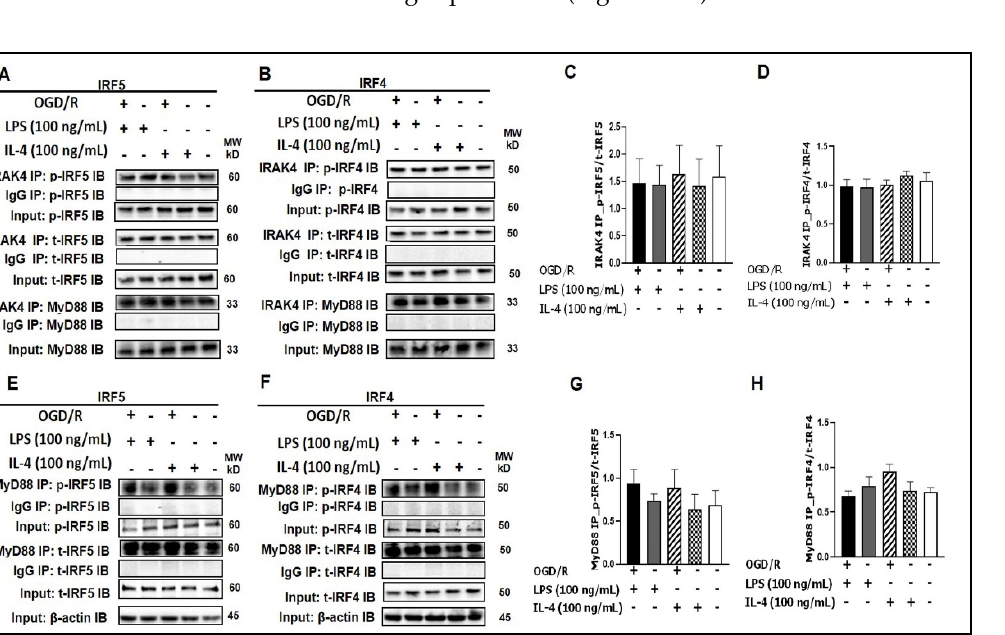
Figure 1. IRF5 and IRF4 bind to MyD88 or IRAK4. ( A , B ) SIM-A9 cell homogenates were subjected to Co-IP with anti-IRAK4 antibody followed by immunoblotting for p-IRF5/p-IRF4, t-IRF5/t-IRF4, and MyD88. ( C , D ) WB optical density quantification of the ratio of p-IRF5 over t-IRF5 ( C ) and p-IRF4 over t-IRF4 ( D ). ( E , F ) SIM-A9 cell homogenates were subjected to Co-IP with anti-MyD88 antibody to detect p-IRF5/p-IRF4 and t-IRF5/t-IRF4. ( G , H ) WB optical density quantification of the ratio of p-IRF5 over t-IRF5 ( G ) and p-IRF4 over t-IRF4 ( H ). IgG controls were from the same homogenates of each treatment. n = 3 independent experiments/per condition. IB, immunoblot; p, phosphorylated; t, total; IgG, immunoglobulin negative control. One-way ANOVA.